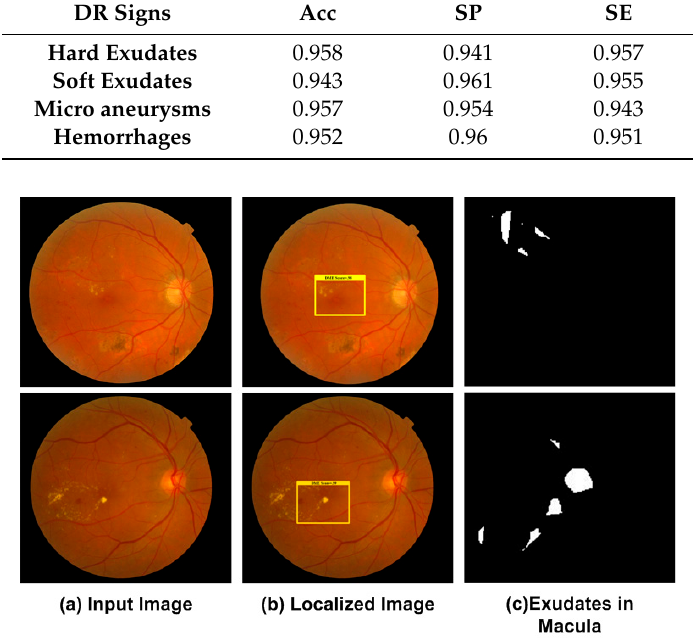
Figure 7. DME segmentation Results.